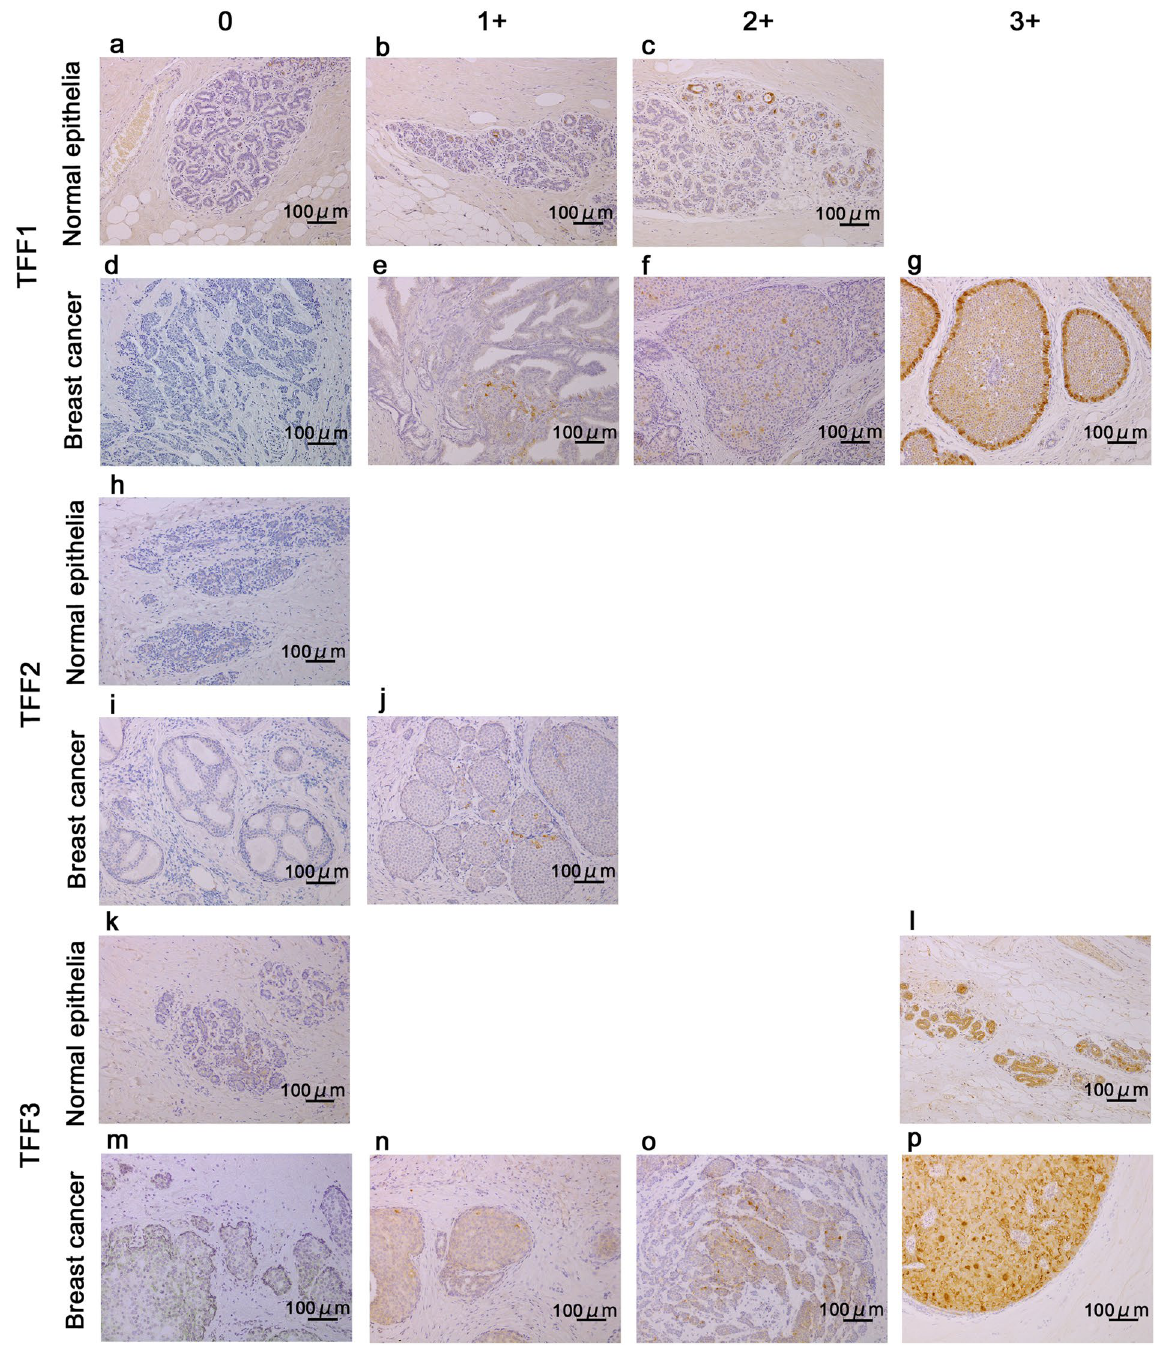
Figure 3. IHC for TFF1, TFF2, and TFF3 for breast cancer tissue and normal epithelial tissue. IHC for TFF1, TFF2, and TFF3 for breast cancer tissue and normal epithelial tissue surrounding breast cancer. Under the view of 10x objective lens, no staining was defined to be -, staining of less than 10% cells to be 1 + , 1050% cells to be 2 + , more than 50% cells to be 3 + . The number of the patients of TFF1 staining in normal epithelial tissue - ( a ), 1 + ( b ) and 2 + ( c ) were 27 (58.7%), 15 (32.6%) and 4 (8.7%), respectively. There was no patient of TFF1 3 + in surrounding normal breast tissue. TFF1 staining in breast cancer tissue - ( d ), 1 + ( e ), 2 + ( f ) and 3 + ( g ) were 9 (19.6%), 11 (23.9%), 20 (43.5%) and 6 (13.0%), respectively. Only 6 (13.0%) cancer was stained by TFF1 weaker than surrounding non-cancerous tissue. TFF2 staining in normal epithelial tissue - ( h ) was 46 (100%), and TFF2 staining in breast cancer tissue - ( i ), 1 + ( j ) were 29 (63.0%) and 17 (37.0%), respectively. TFF3 staining in normal epithelial tissue - ( k ) and 3 + ( l ) were 36 (78.3%) and 10 (21.7%), respectively. There was no patient of TFF3 1 + and TFF3 2 + staining in surrounding normal breast tissue. TFF3 staining in breast cancer tissue - ( m ), 1 + ( n ), 2 + ( o ) and 3 + ( p ) were 2 (4.4%), 10 (21.7%), 10 (21.7%) and 24 (52.2%), respectively. Only 4 (8.7%) cancer was stained by TFF3 weaker than surrounding non-cancerous tissue (Scale bar: 100 μ